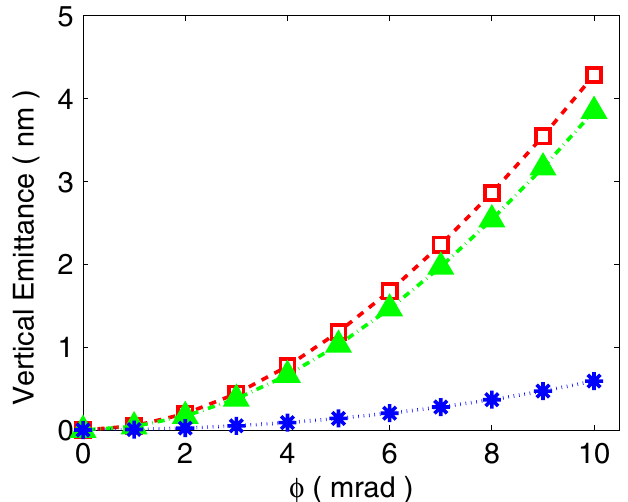
FIG. 10. (Color) The vertical emittance before (red line) and after (blue line) harmonic correction. For this random seed, the vertical emittance arises mainly from the vertical dispersion function, and thus the coupling correction (green line) has a little effect on the vertical emittance.